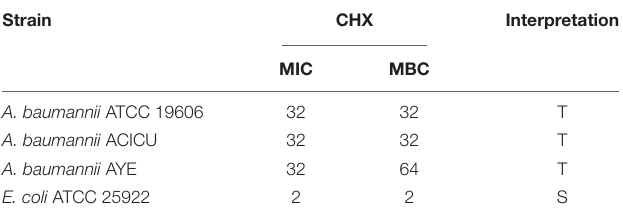
TABLE 1 | MIC (mg/L) and MBC (mg/L) values of CHX against A. baumannii strains and E. coli reference strain. Strain CHX Interpretation MIC MBC